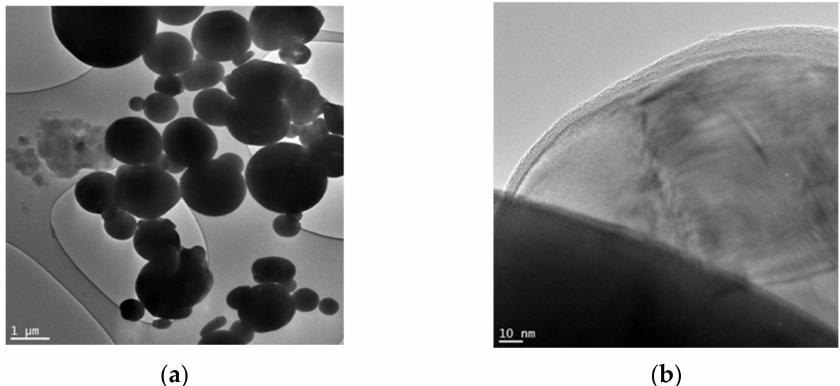
Figure 1. SEM images of Al powder: ( a ) General view, ( b ) High magnification. The particles of Al micropowder are not sintered and coated with a stable oxide shell consisting only of a monovalent oxide [18]. The mean surface diameter of particles is 6.5 µ